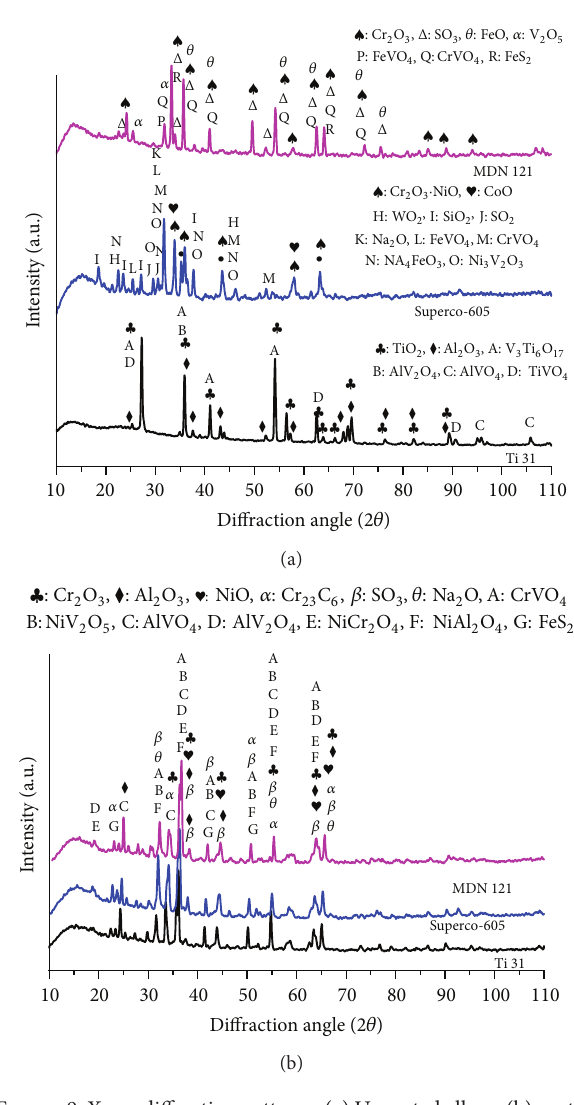
Figure 9: X-ray diffraction patterns. (a) Uncoated alloys, (b) coated 25% (Cr 3 C 2 -25(Ni20Cr))+NiCrAlY, coated Ti-31, Superco-605,